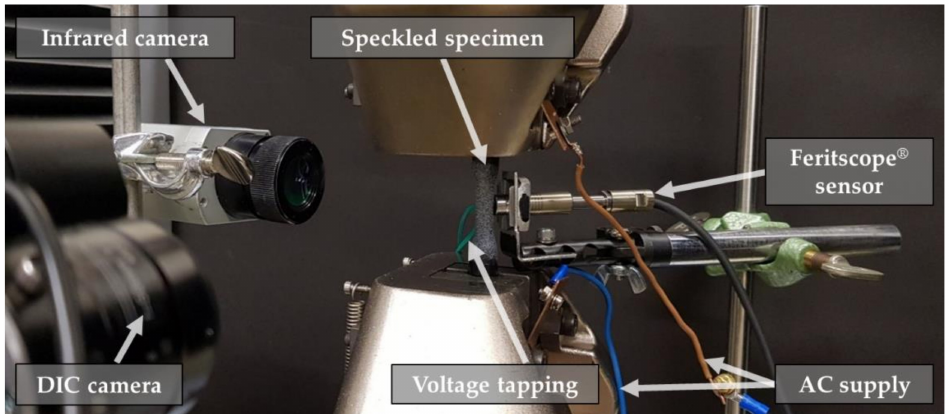
Figure 7. Instrumented low-strain-rate tensile test